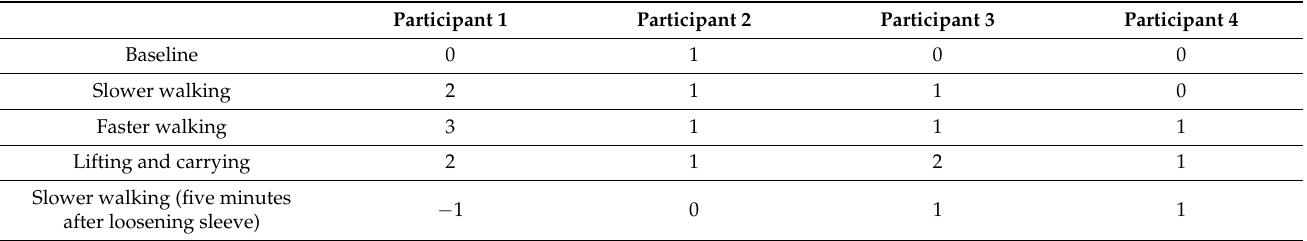
Table 1. Thermal Sensation results for each participant for the Form-Fitting Leg Sleeve, where − 4 represents very cold, − 3 cold, − 2 cool, − 1 slightly cool, 0 neutral, 1 slightly warm, 2 warm, 3 hot, and 4 very hot.